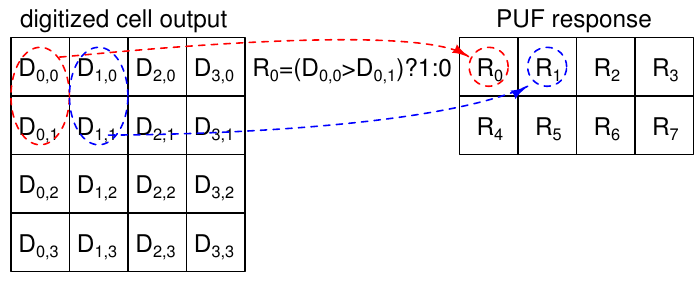
Figure 4. Operation diagram of basic signal processing to generate PUF